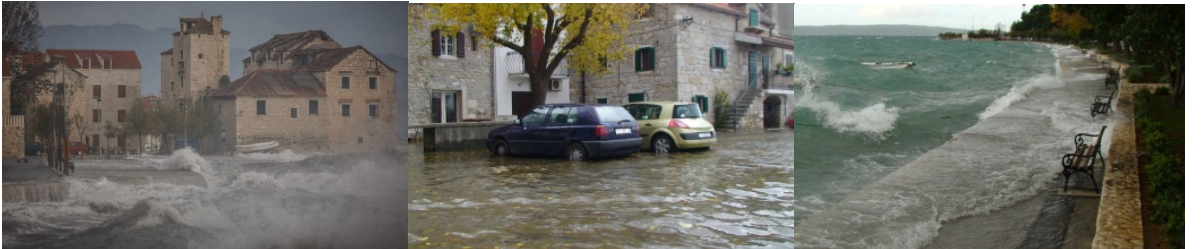
Figure 2. Coastal flooding events in the city of Kaštela.